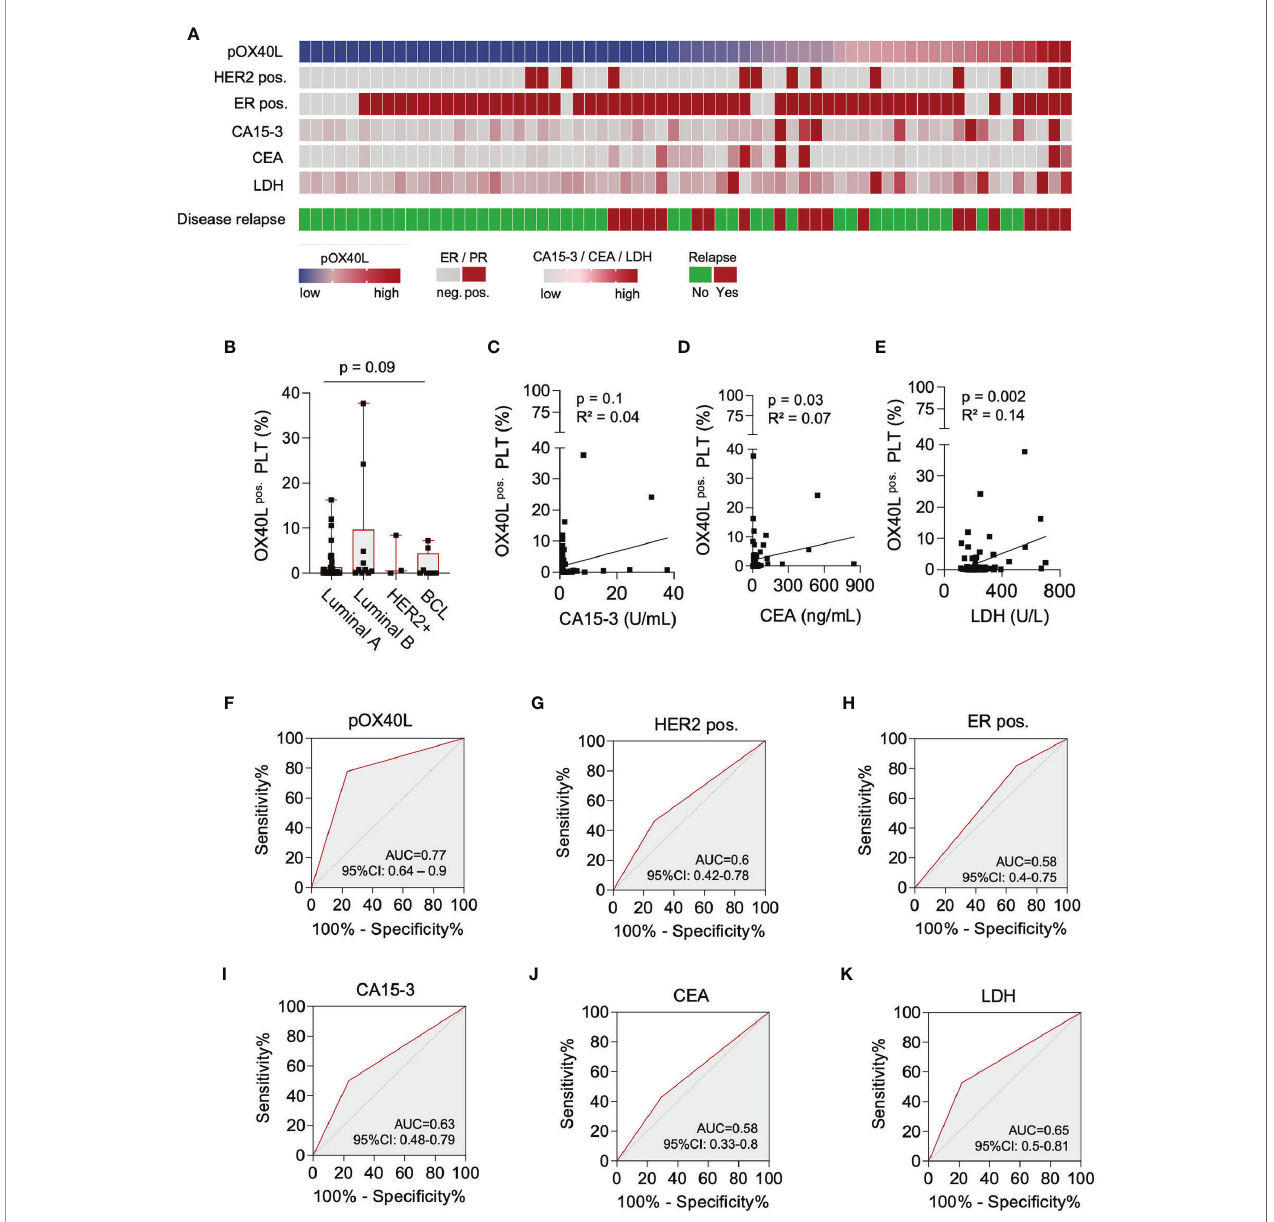
FIGURE 3 | Predictive value of pOX40L in breast cancer relapse. (A) Comparative analysis of pOX40L and the clinical markers HER2, ER, CA 15-3, CEA and LDH. (B) Association of pOX40L expression and different breast cancer subtypes. (C-E) Correlation of pOX40L and conventional tumor marker including CA15-3 (C) , CEA (D) and LDH (E) . (F – K) Predictive value of pOX40L (F) , HER2 (G) , ER (H) , CA15-3 (I) , CEA (J) and LDH (K) expression for disease relapse was analyzed using ROC (Area under the ROC curve)